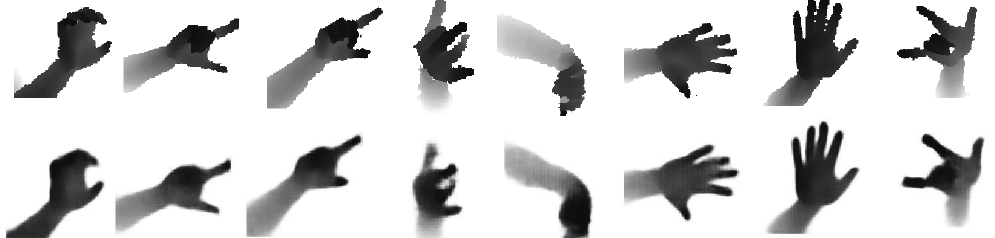
Figure 7. Samples generated by the only GAN for different poses from the test set. Top: Ground-truth depth image. Bottom: Synthesize depth image using our learned hand model (Best viewed on